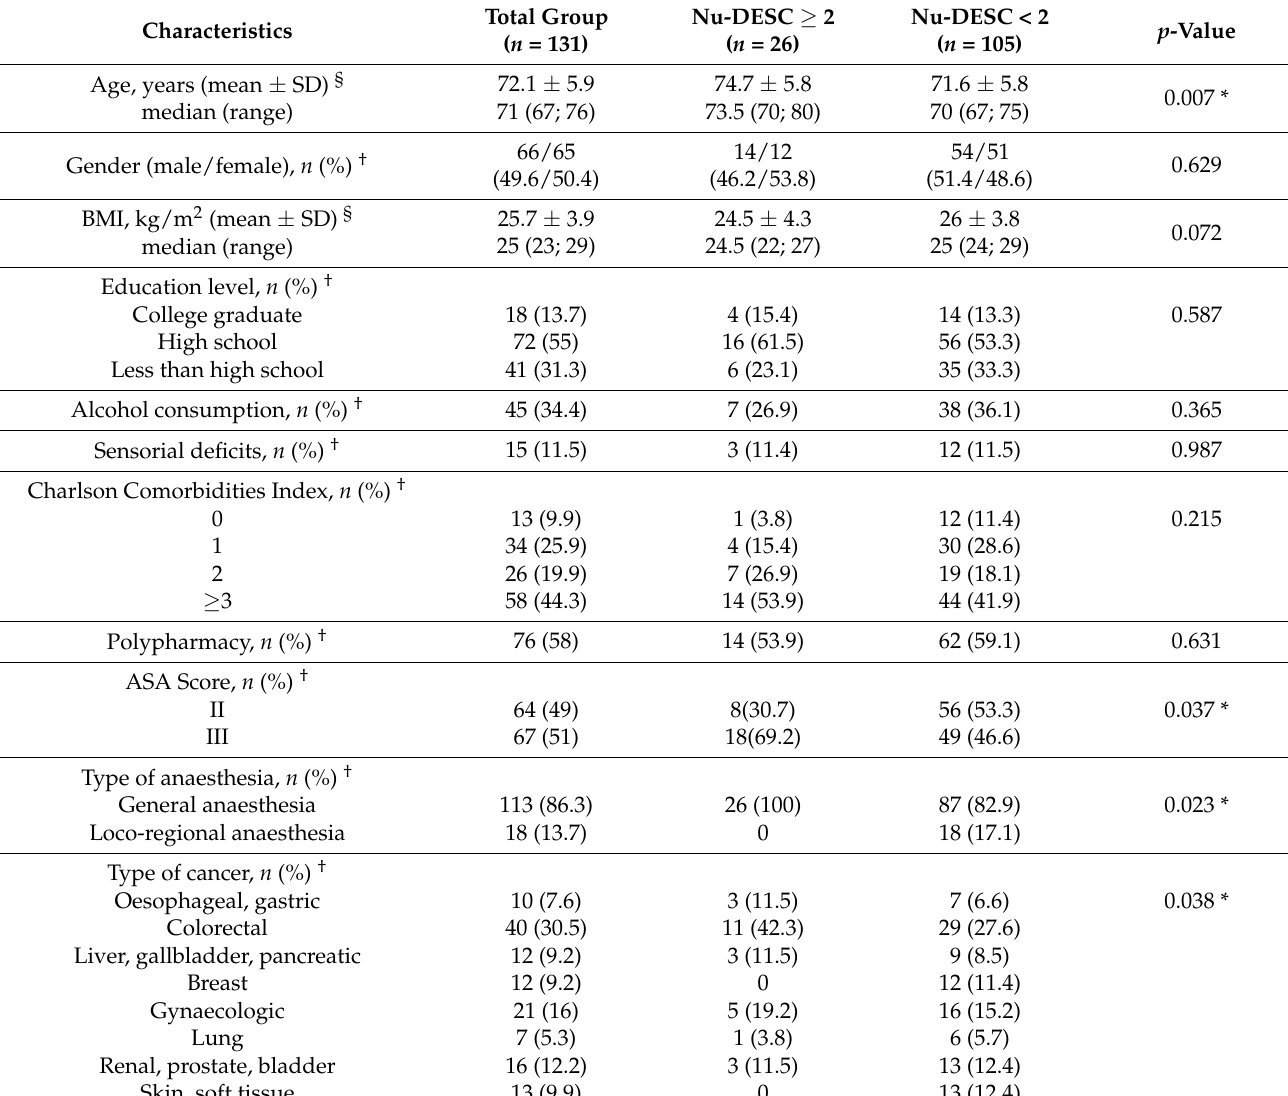
Table 2. Perioperative variables in elderly cancer patients according to Nu-DESC